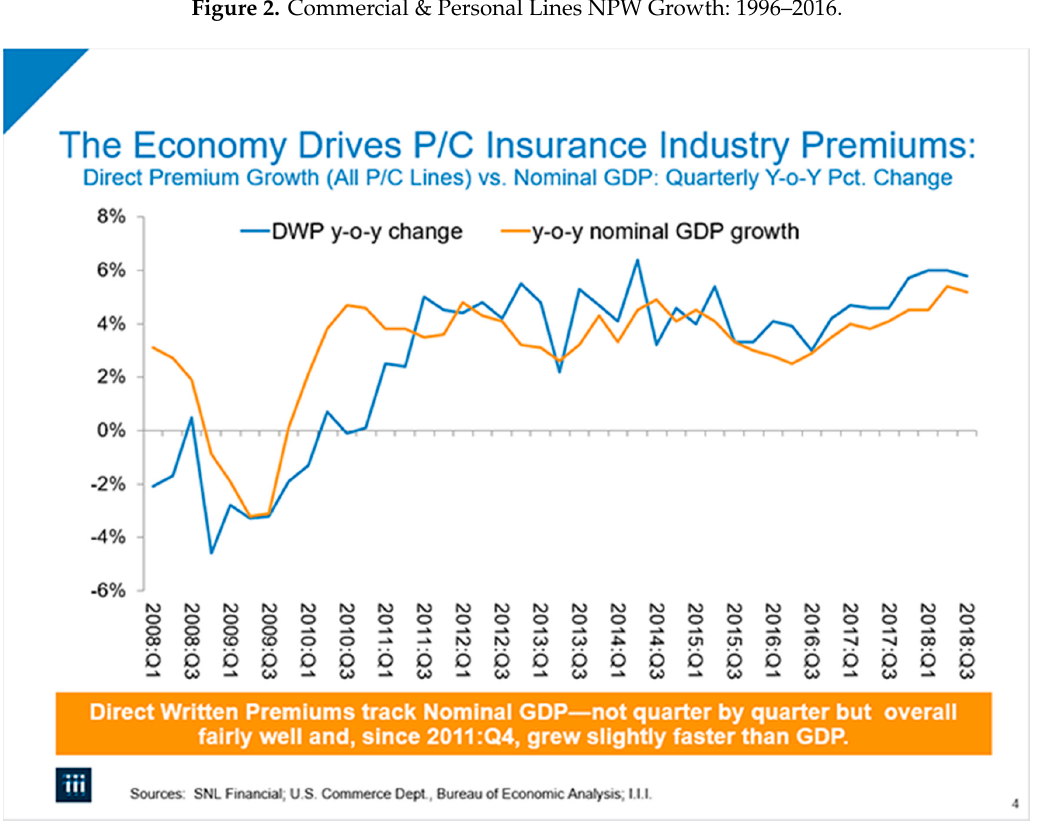
Figure 3. The Economy Drives P/C Insurance Industry Premiums.